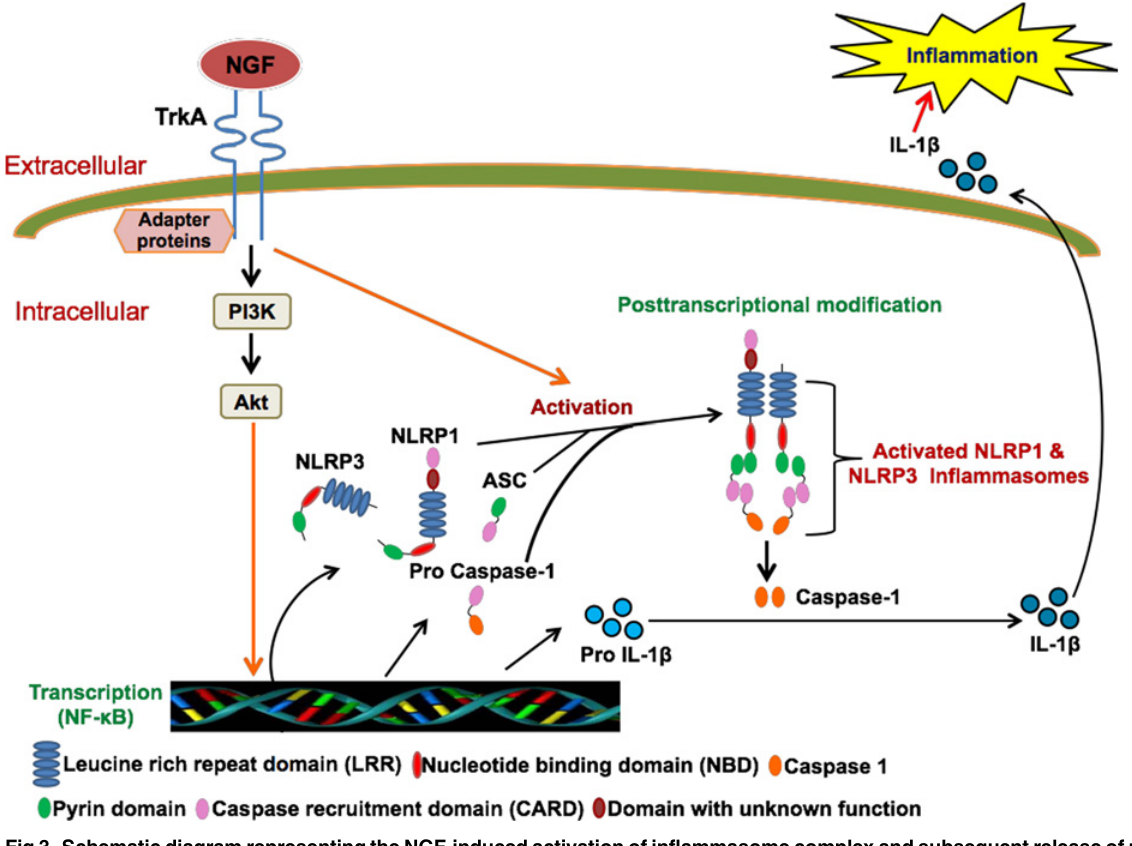
Fig 3. Schematic diagram representing the NGF-induced activation of inflammasome complex and subsequent release of mature IL-1 β . Briefly, NGF/TrkA interaction modulates the IL-1 β release by acting at both transcriptional and posttranscriptional level. At transcriptional level, NGF upregulates the mRNA expression of NLRP1, NLRP3, procaspase-1 and proIL-1 β . By upregulating the NLRP1/NLRP3 mRNA, NGF induces formation of active inflammasome complex, which converts pro IL-1 β to mature IL-1 β